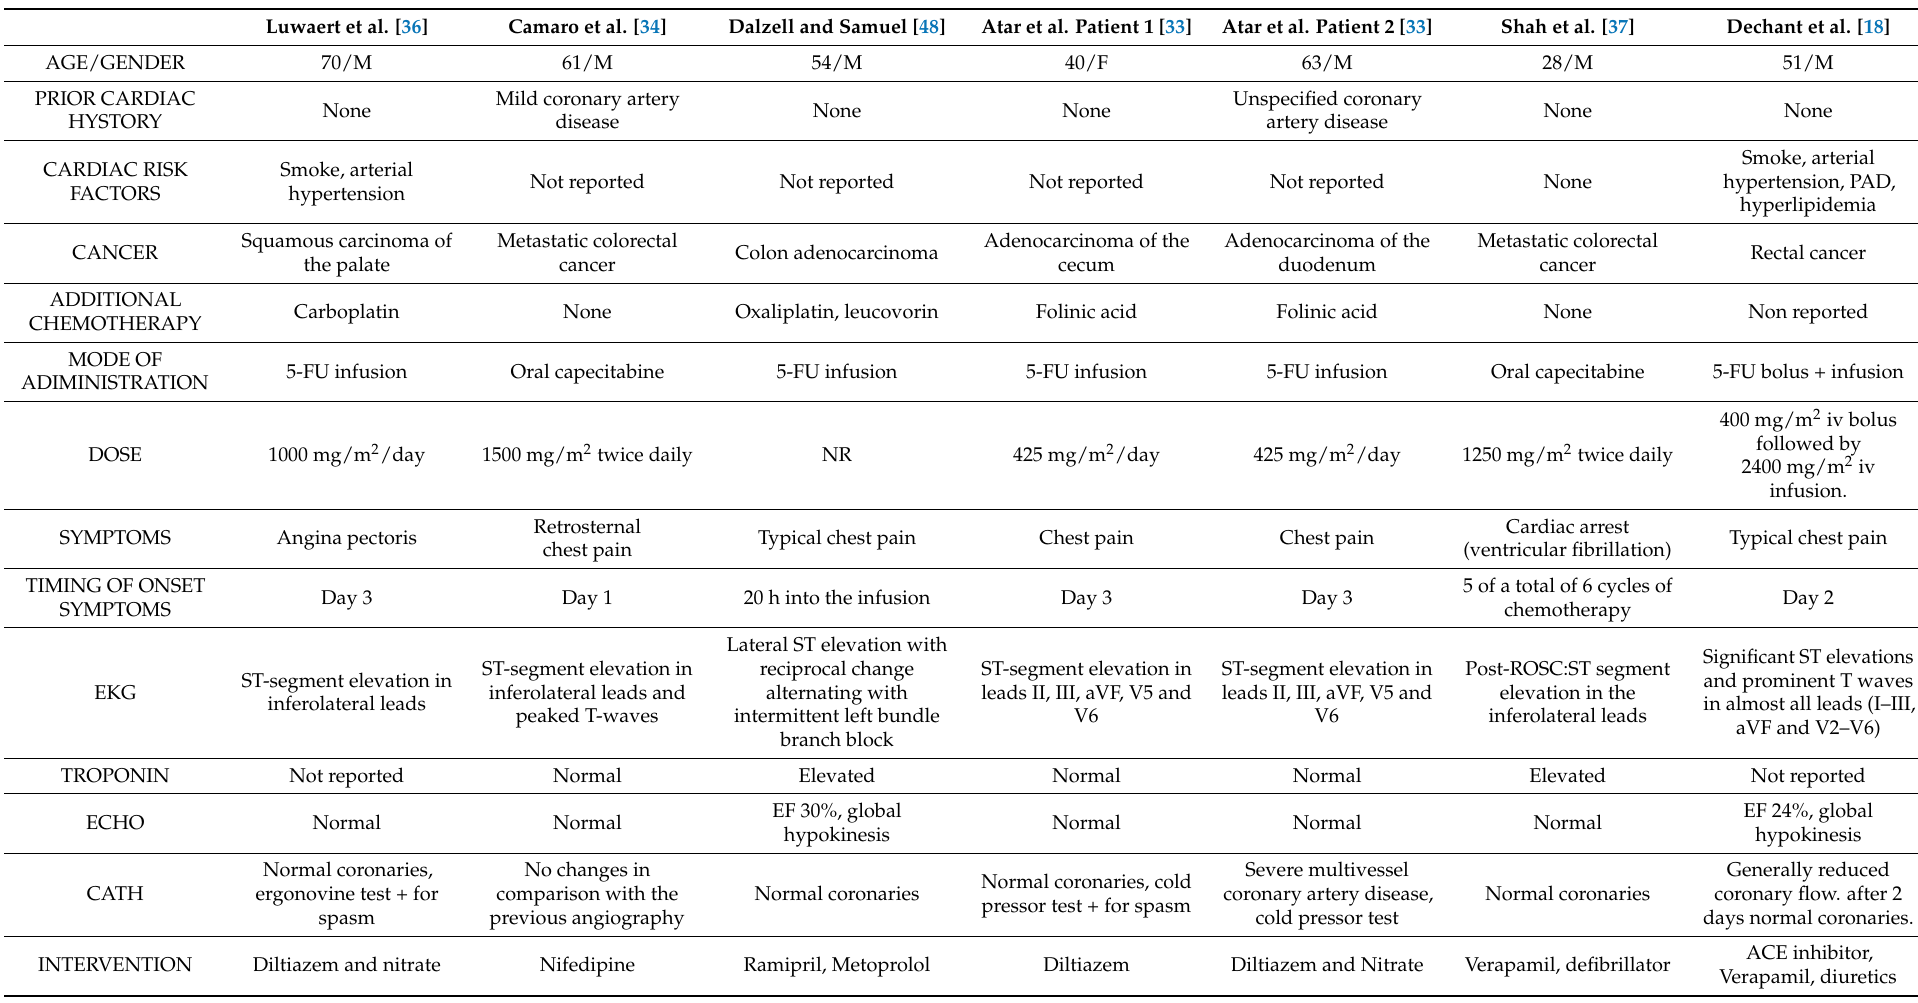
Table 1. Previously well-documented described cases of ACS following coronary spasm (proved or likely) associated with fluoropyrimidine use. Differences in echocardiographic features and troponin levels are probably attributable to differences in coronary spasm extension and duration, even though other concomitant pathophysiological causes, such as myocardial inflammatory injury and vascular endothelial dysfunction, cannot be ruled